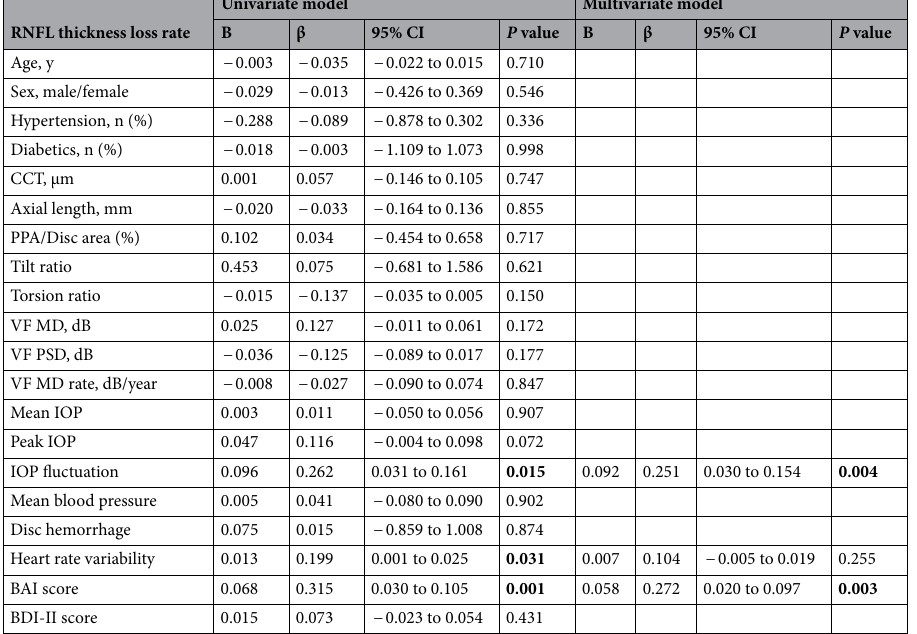
Table 8. Regression analysis of factors associated with the RNFL thickness loss rate. B, non-standardized coefficient; β, standardized coefficient; CI, confidence interval; CCT, central corneal thickness; PPA, peripapillary atrophy; VF, visual field; MD, mean deviation; PSD, pattern standard deviation; RNFL, retinal nerve fiber layer; IOP, intraocular pressure; BAI, Beck Anxiety Inventory; BDI-II, Beck Depression Inventory-II. Statistically significant values appear in boldface.